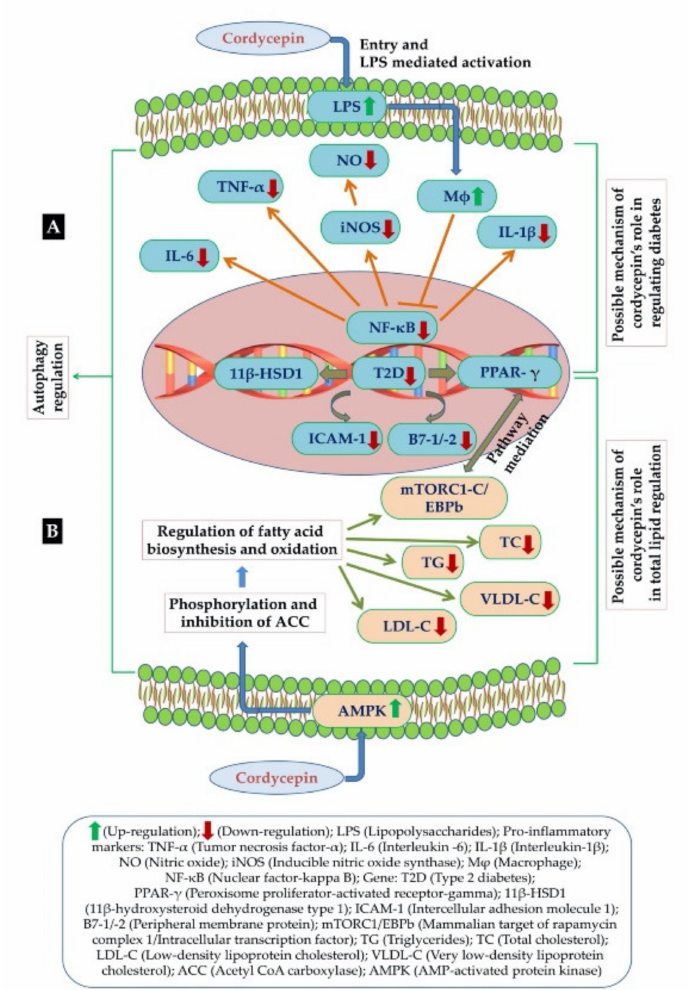
Figure 4. ( A ) Possible mechanism of cordycepin for its anti-diabetic activity ( B ) Possible mechanism of cordycepin in regulation of fat metabolism in hyperlipidemia [47].